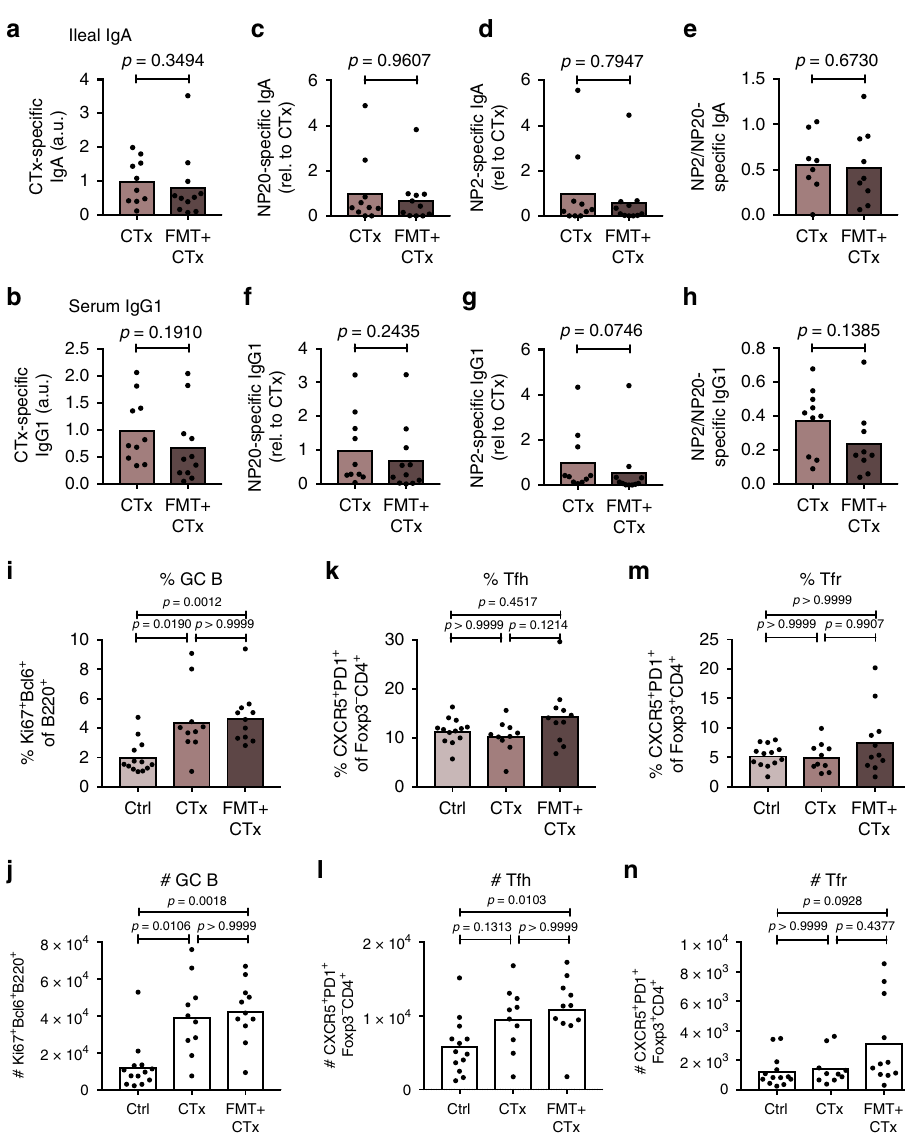
Fig. 8 Faecal microbiota transplantation does not enhance NP-CTx-speci fi c immune responses in the gut. 21-month-old C57BL/6 mice received faecal microbiota transplantation (FMT) or PBS by oral gavage as described above, followed by three oral immunisations with NP-CTx once a week. After three weeks, NP-CTx-speci fi c antibody levels were analysed in PBS-gavaged, NP-CTx-immunised 23-months-old C57BL/6 mice (CTx) compared with aged mice receiving FMT plus NP-CTx (FMT + CTx). Peyer ’ s patch (PP) germinal centre (GC) responses in these mice were compared with naïve, 23-month-old C57BL/6 mice (Ctrl). a – d Antigen-speci fi c IgA levels against CTx ( a ) and NP ( b – d ) in faecal contents from the ileum were assessed by ELISA. NP20-